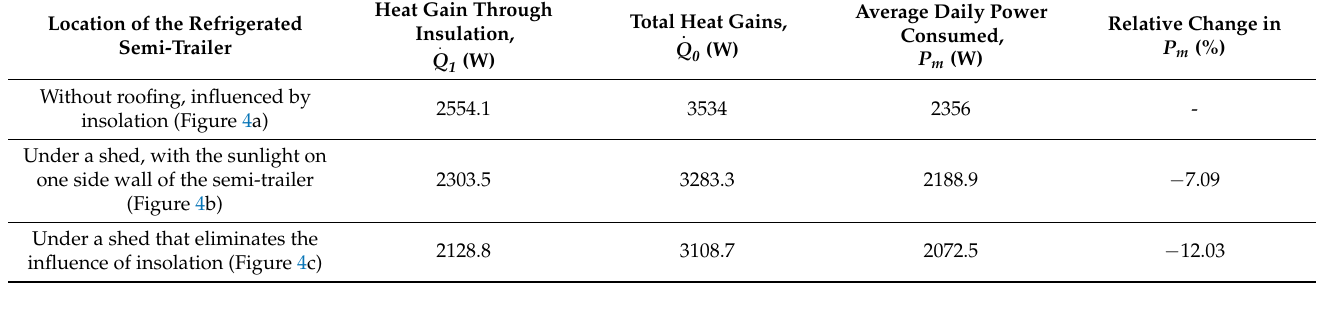
Table 3. The results of heat load calculations and the average daily power consumed by the refrig- eration unit of a semi-trailer in different parking locations.